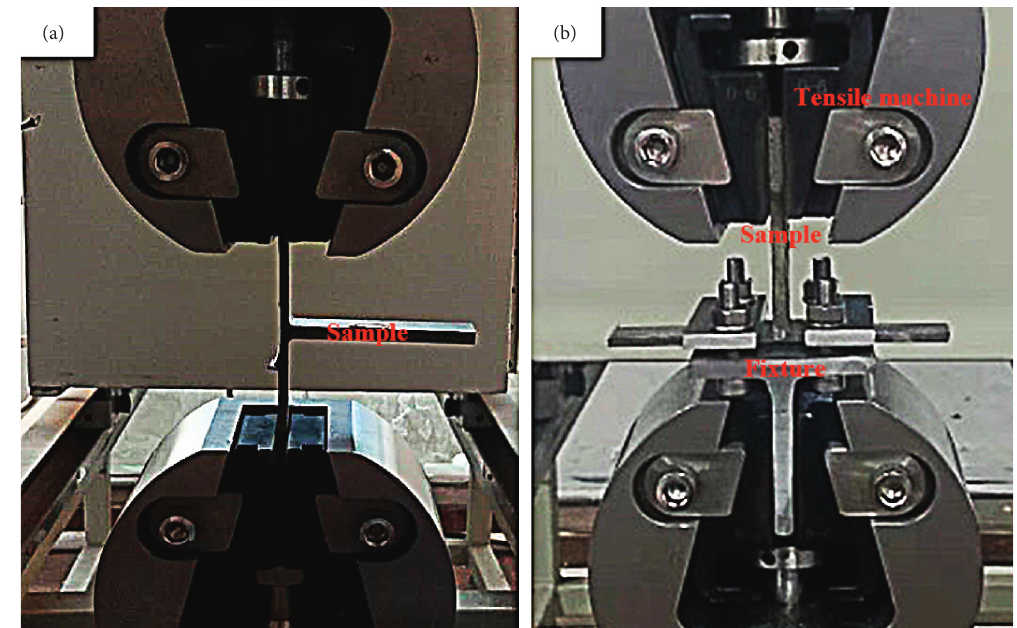
Figure 5: Real pictures of tensile test. (a) Along the skin and (b) along the stringer.